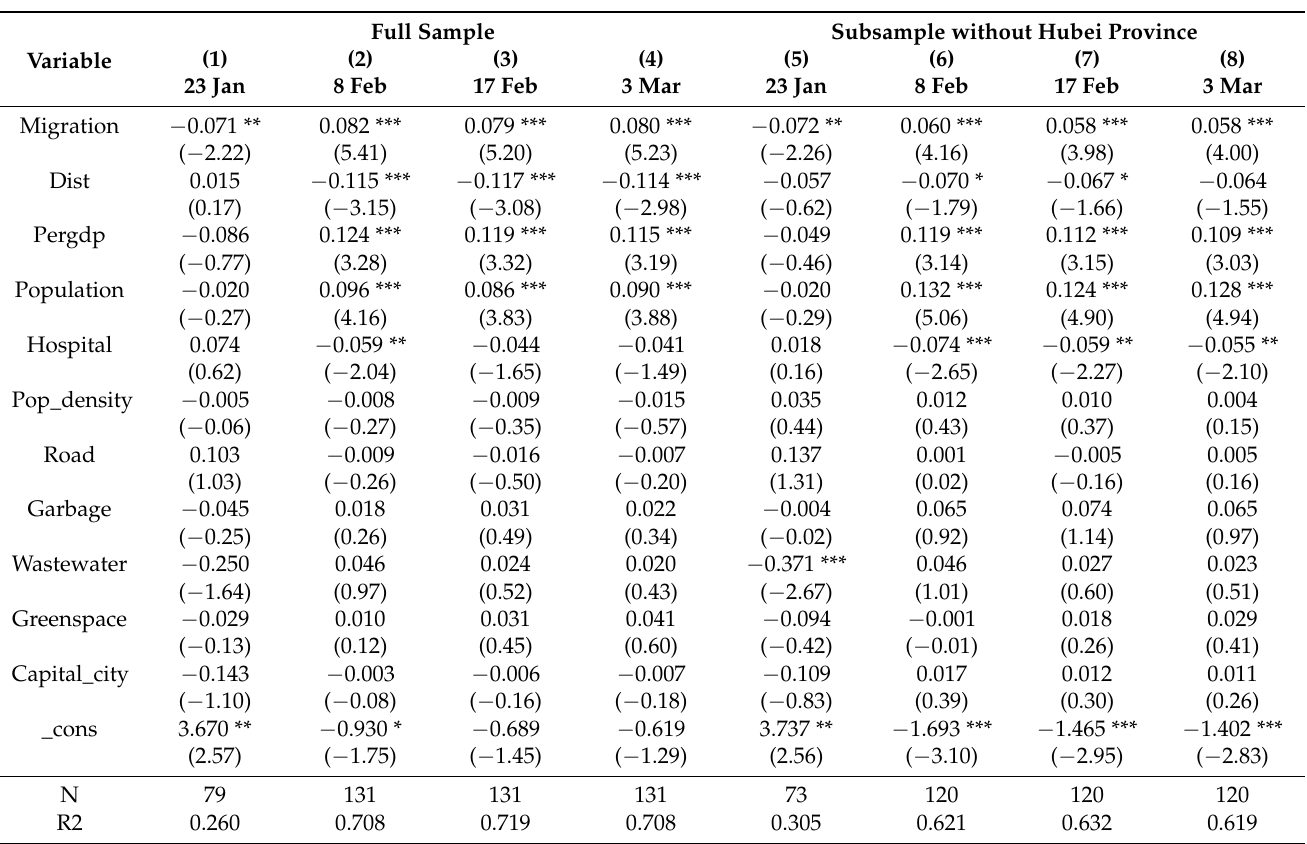
Table 3. Empirical estimation results with dependent variables of the accumulated number of confirmed COVID-19 cases in cities on 23 Jan, 8 Feb, 17 Feb, and 3